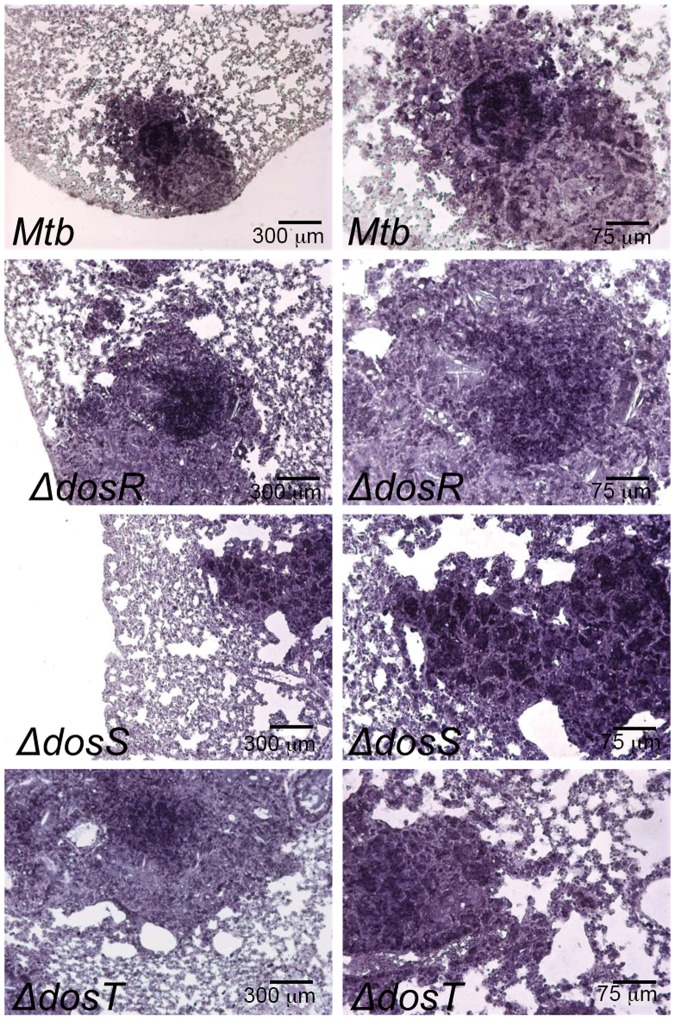
In-Situ hybridization.
In-Situ hybridization detected the presence of Mtb specific sigA transcripts in mice lung samples (derived at chronic phase of infection) infected with Mtb, Mtb:ΔdosR, Mtb:ΔdosS and Mtb:ΔdosT strains. Representative images with low (left) and high (right) magnification for each Mtb strain is shown.